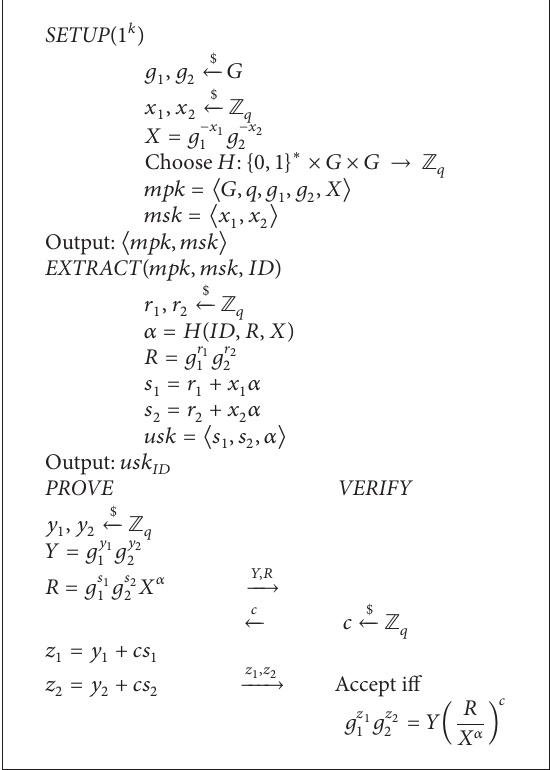
Algorithm 3: Definition of the Twin-Schnorr-IBI